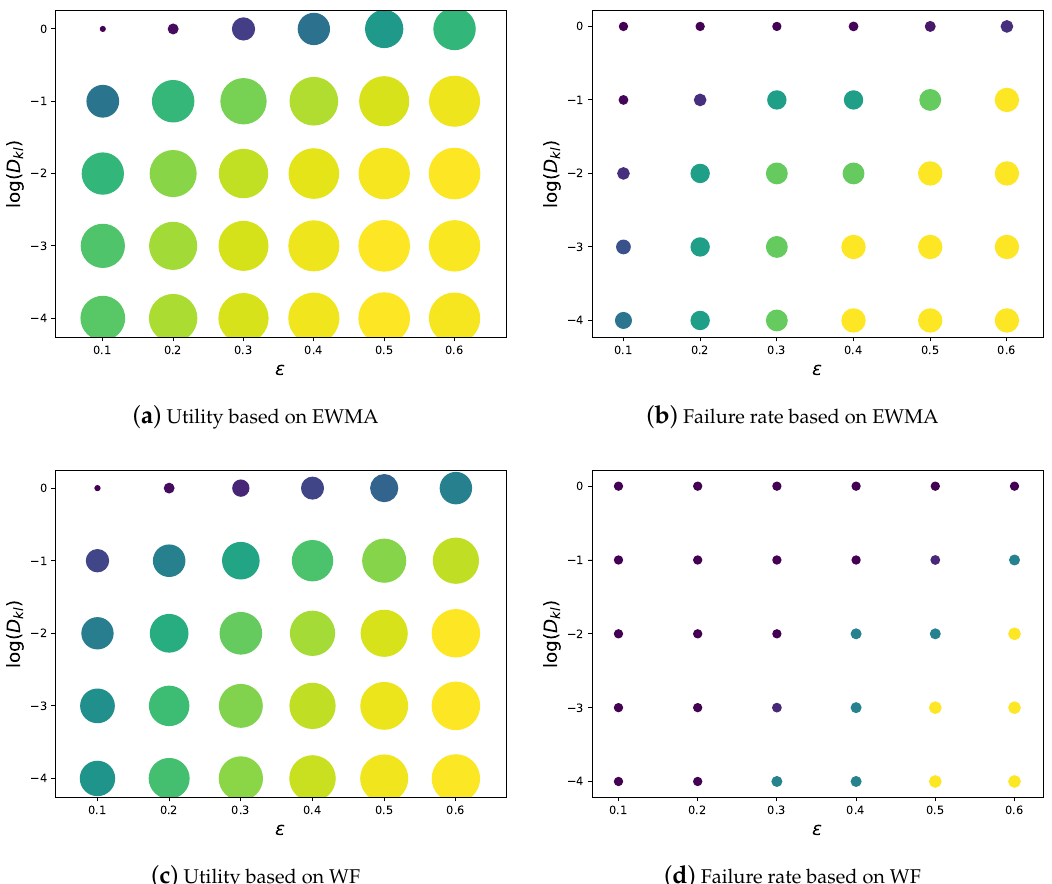
Figure 7. Impact of parameters (cid:101) and D KL . We present the amount of utility in ( a , c ) and the failure rate in ( b , d ) using the size of each circle, respectively.